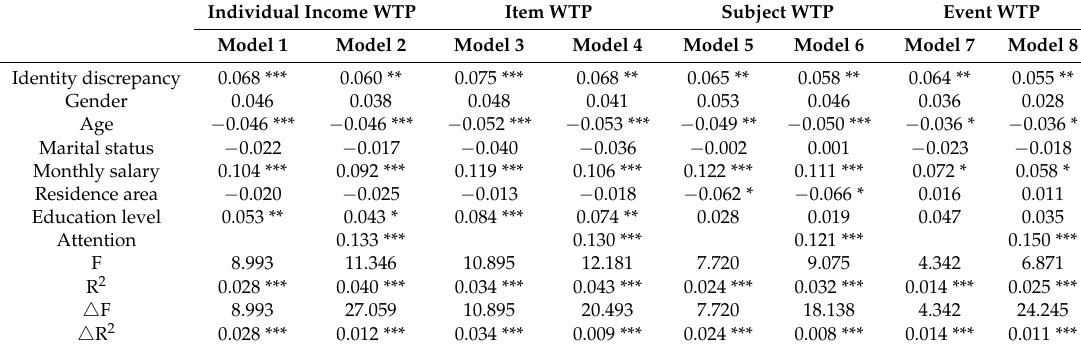
Table 7. Regression between attention to occupational safety and health connotation and WTP (n =